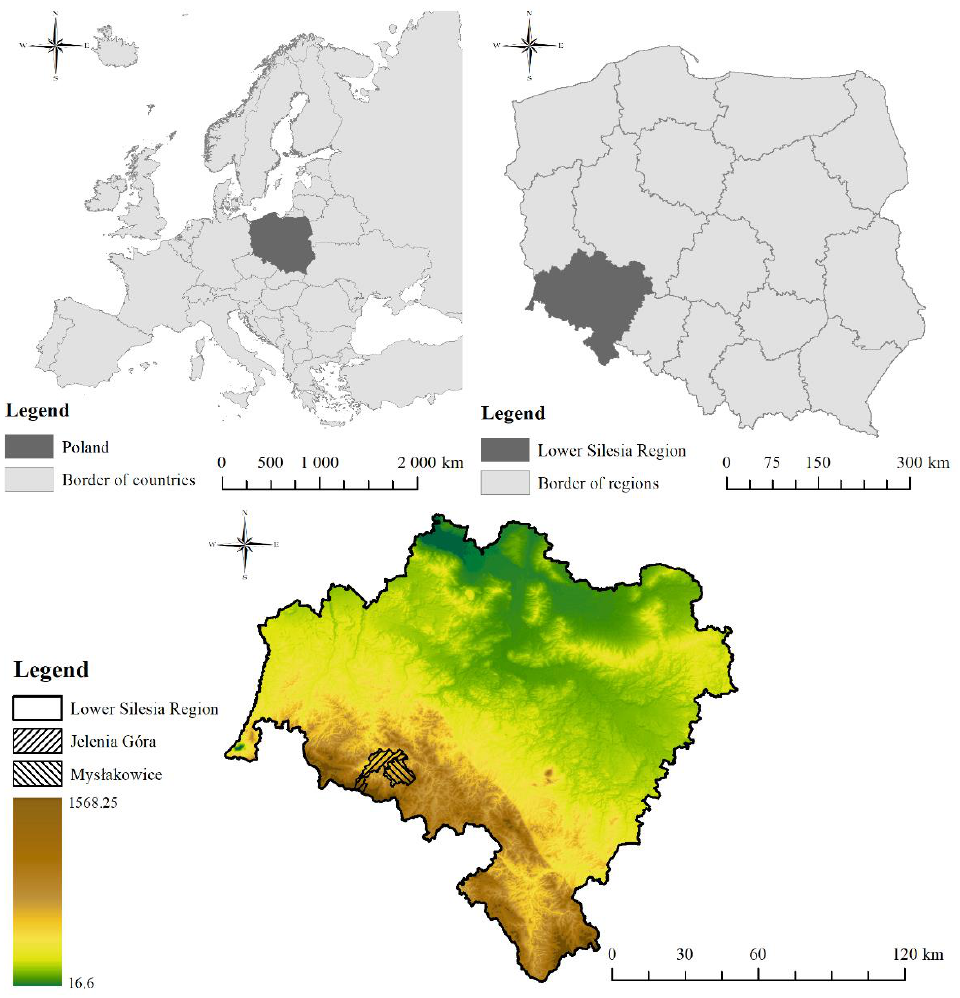
Figure 1. Location of the communities on the background of Europe, Poland, and the Lower Silesia region.